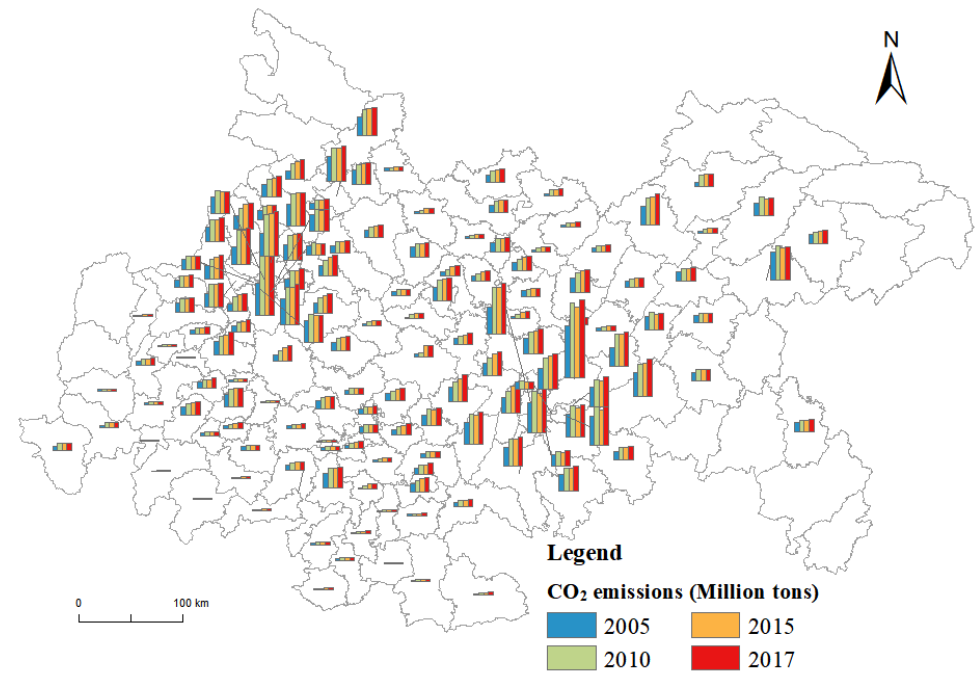
Figure 2. The spatial and temporal distributions of carbon emissions in 2005, 2010, 2015 and 2017.